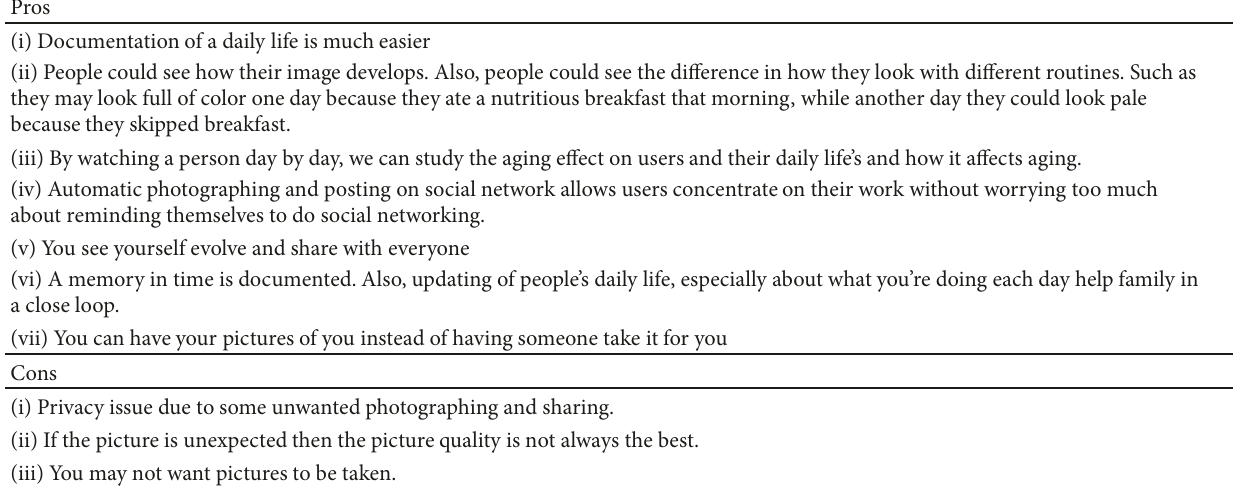
Table 2: Collected pros and cons of robotic photography in terms of its social effect.